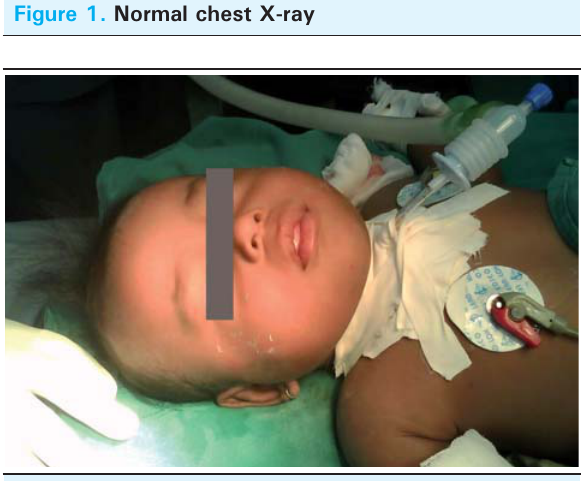
Figure 2. Tracheostomy